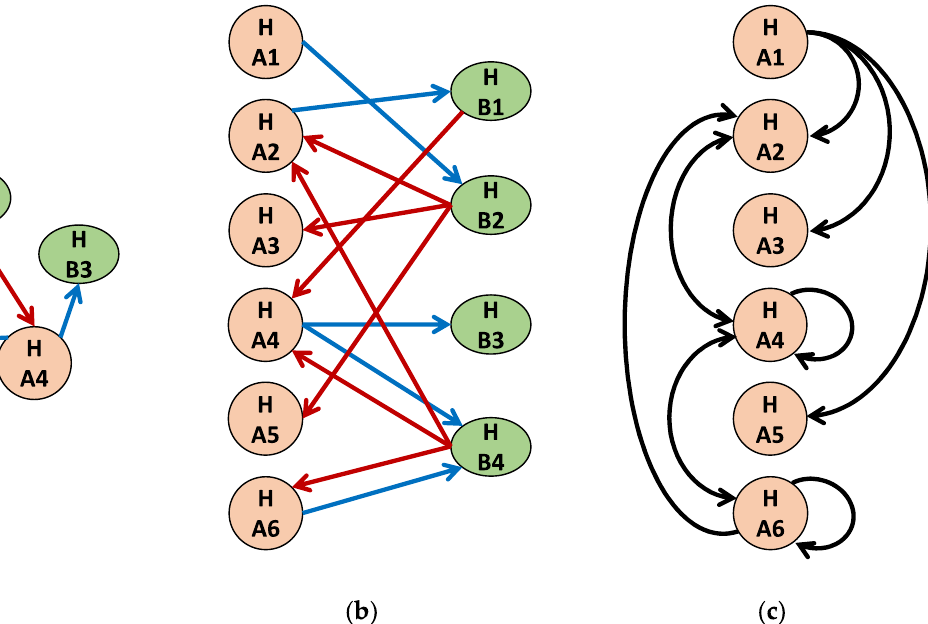
Figure 5. Interaction network among hosts. Blue line denotes transmission from Host species A to Host species B (e.g., parasite eggs from main host to intermediary host). Red line denotes transmission from Host species B to Host species A (e.g., parasite larva from intermediary host to main host). The lines can also be weighted based on volume of parasite loading. ( a ) sample network; ( b ) network is converted to a bipartite graph; ( c ) graph projection where black lines denote transmission interaction via an intermediate host. Note that a multipartite (e.g., tripartite) interaction network can also be studied to account for the role of the parasites.